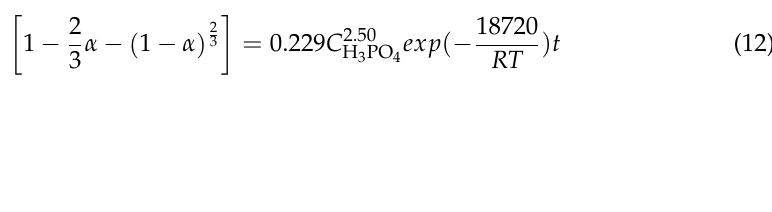
Table 5. Apparent rate constants for kinetics models and correlation coefficients at slow reaction stage. Diffusion through the Liquid Film Chemical Reaction Parameter